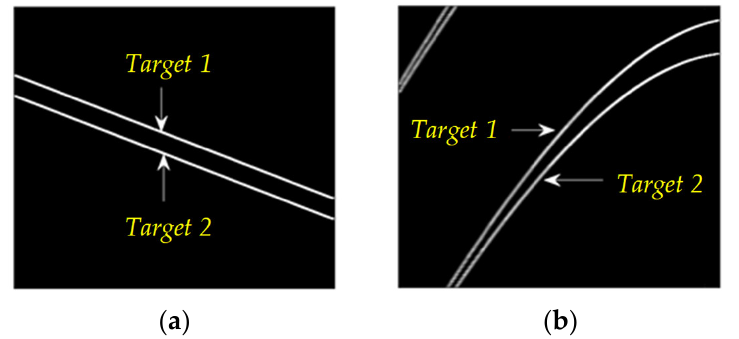
Figure 6. Azimuth TFD of two targets in Conv-SAR and CF-SAR. ( a ) Conv-SAR. ( b ) CF-SAR.